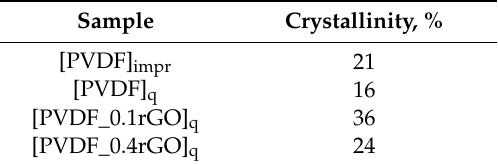
Table 2. Crystallinity of the studied samples derived from the DSC